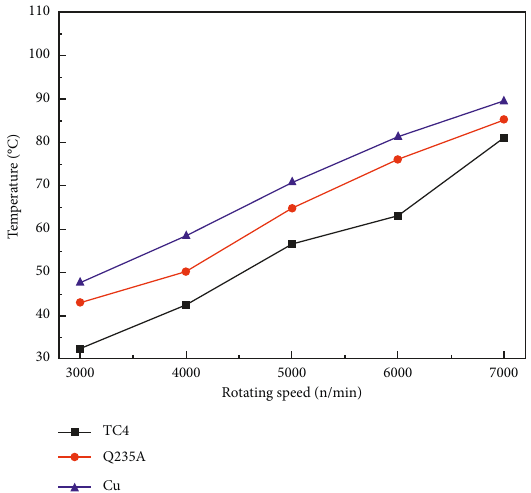
Figure 4: Temperature–speed curves of different materials.